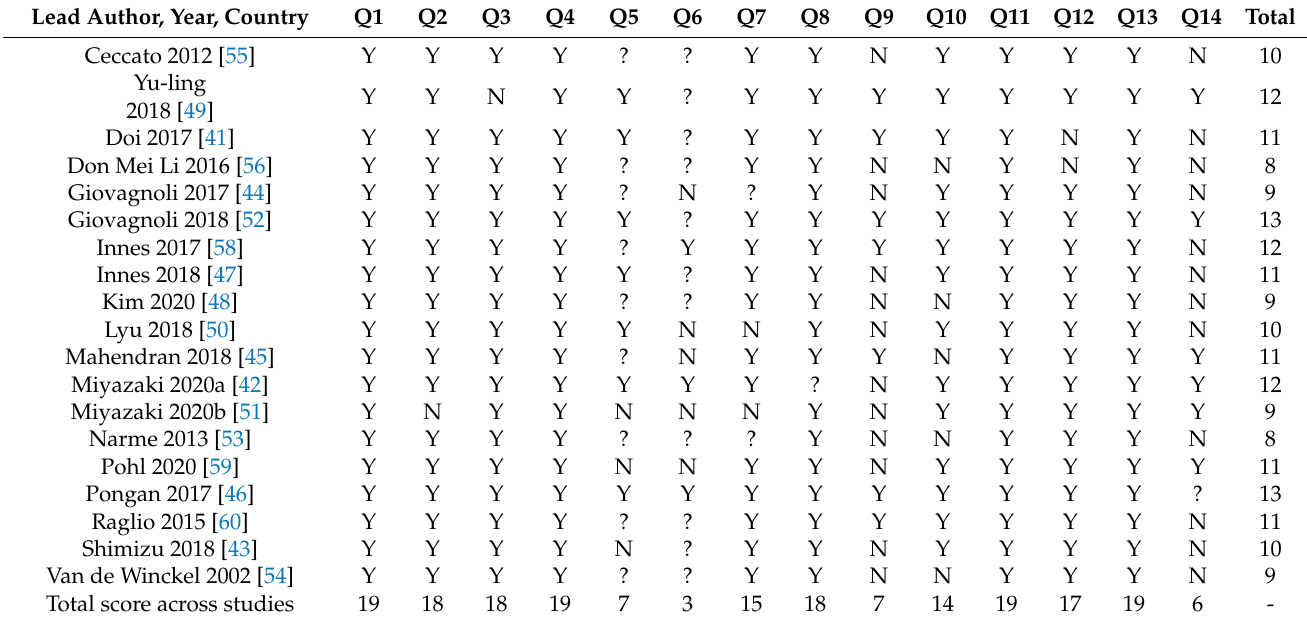
Table 3. Quality assessment scores of included studies using modified Delphi